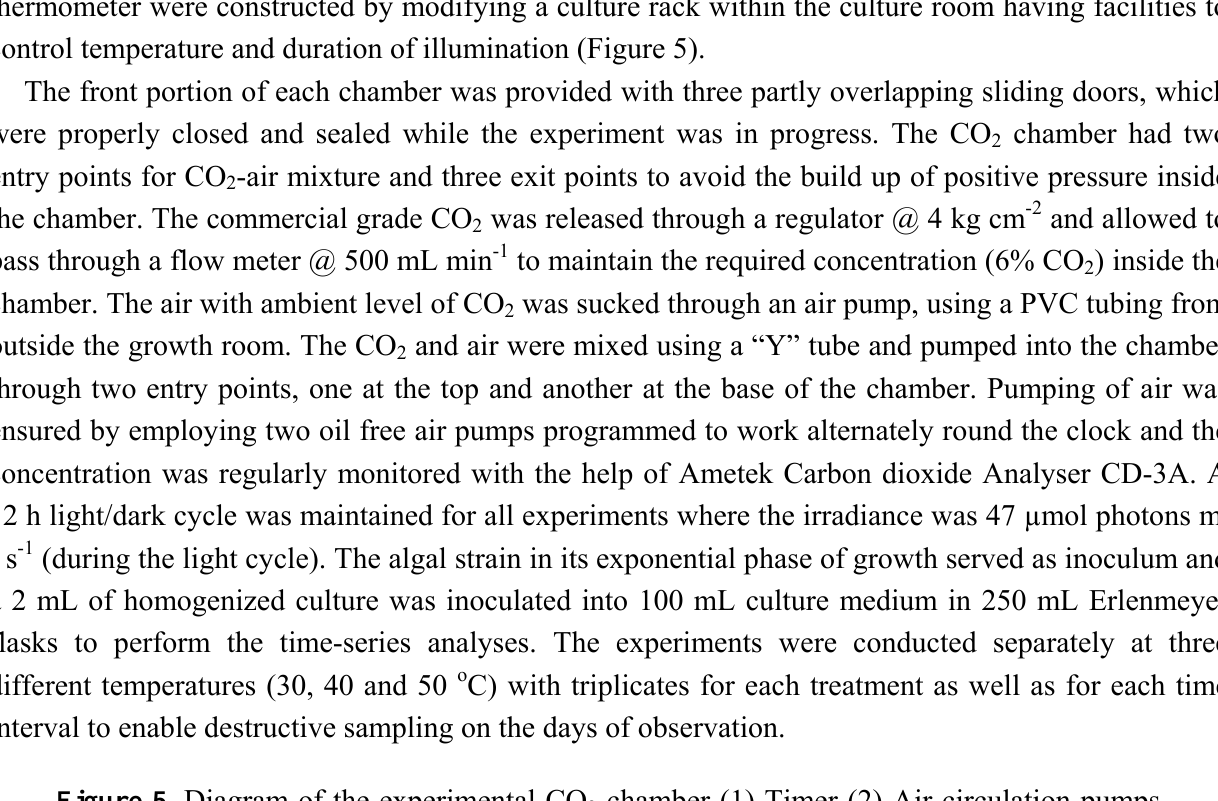
chamber (1) Timer (2) Air circulation pumps 2 chamber (7) Algal culture (8) 2